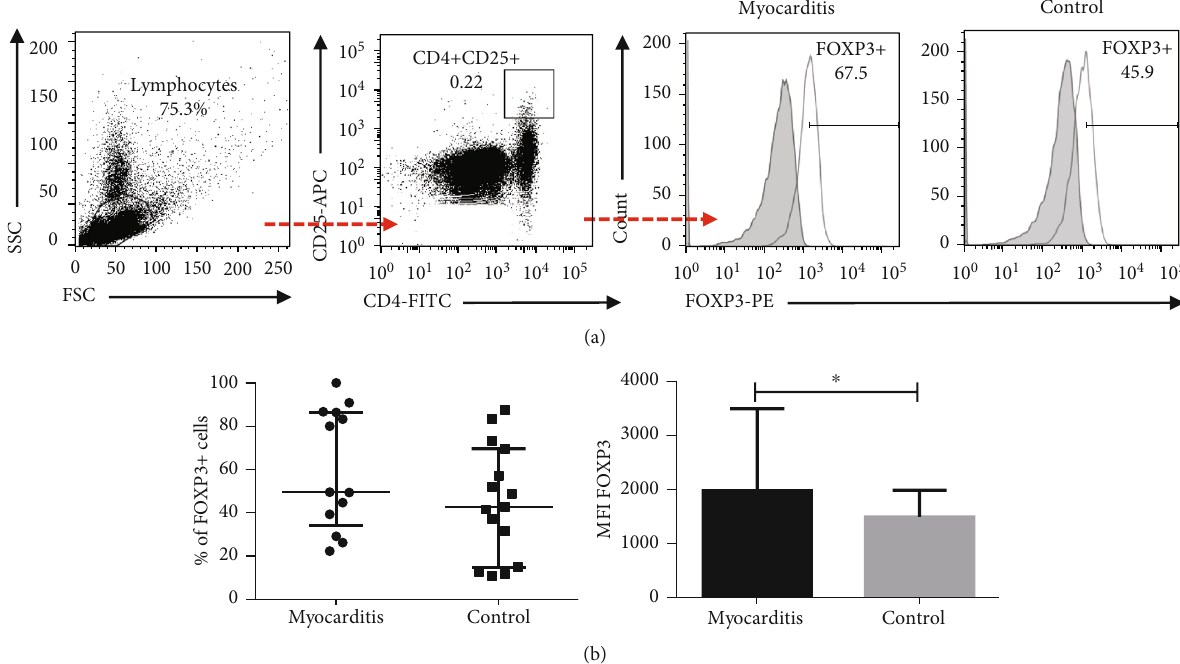
Figure 5: Regulatory T cells from myocarditis patients and controls. PBMC from myocarditis and control subjects were immunostained, and then cells were analyzed by fi ve-color fl ow cytometry. (a) Gating tree for CD4 + CD25 + FOXP3 + cells. (b) Percentage of FOXP3+ cells in Treg cells from myocarditis patients and controls. (c) Median fl uorescence intensity (MFI) of FOXP3+ cells in CD4 + CD25 + lymphocytes from myocarditis patients and controls. ∗ p < 0 : 05 , ∗∗ p < 0 : 01